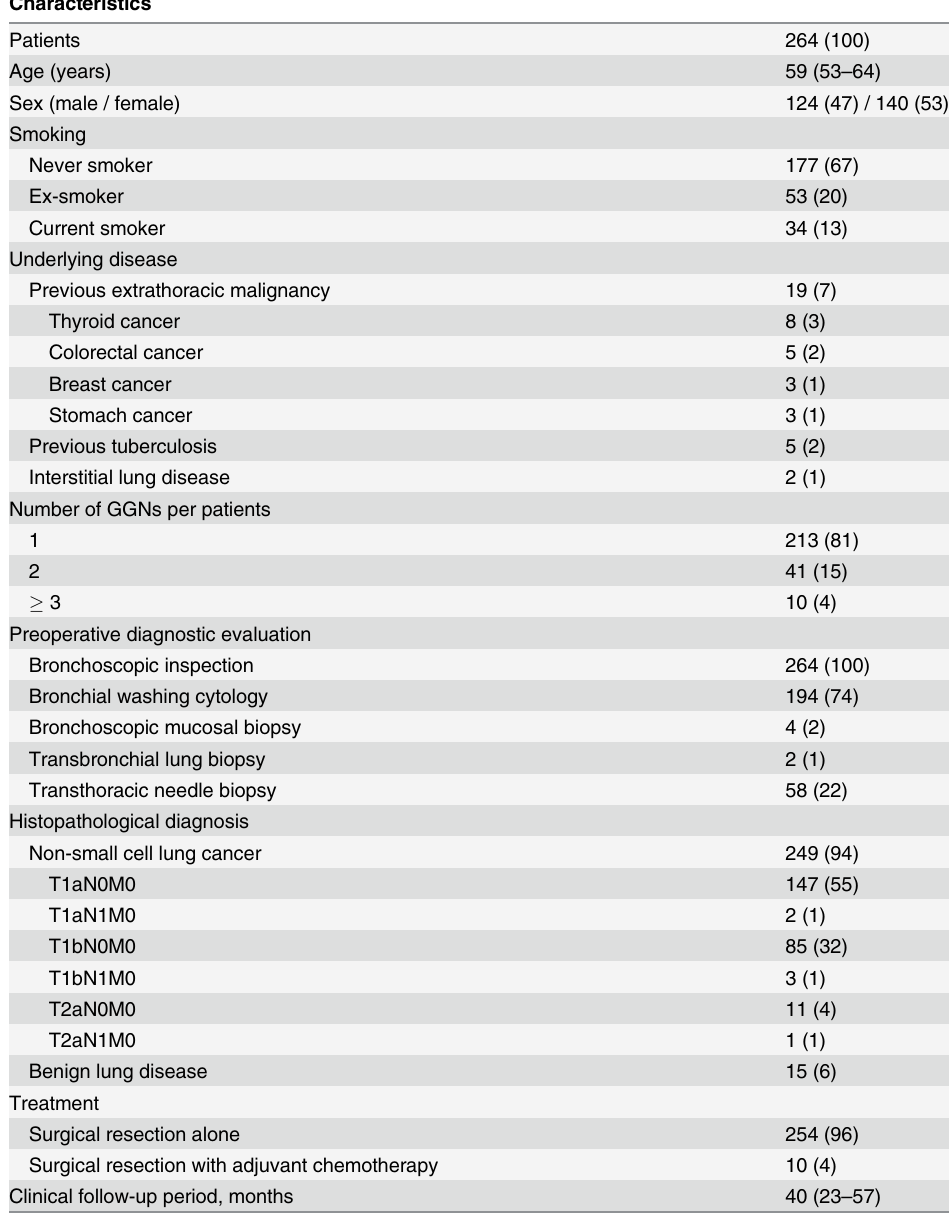
Table 1. Characteristics of the study patients.